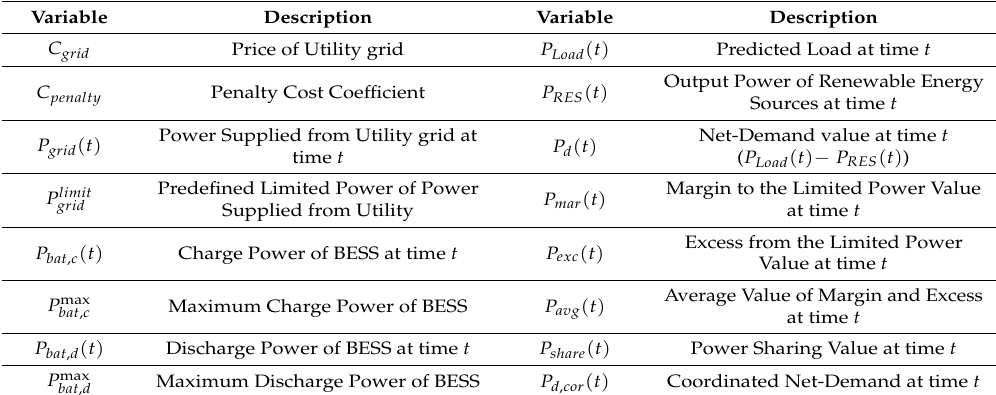
Table 3. A description of the variable